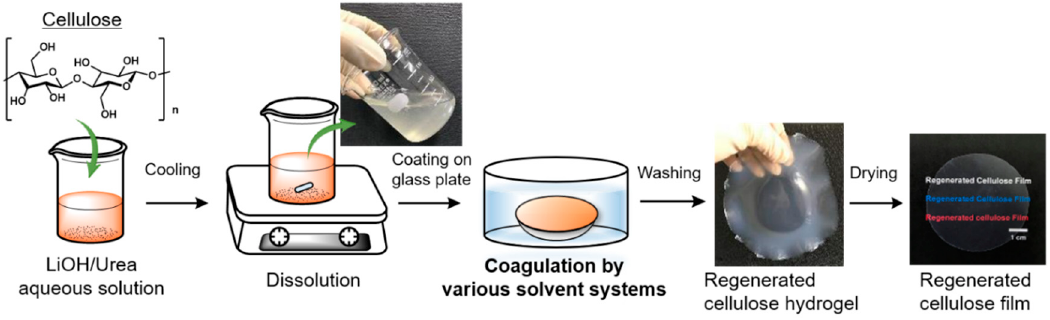
Figure 1. Schematic representation of the RC film preparation.